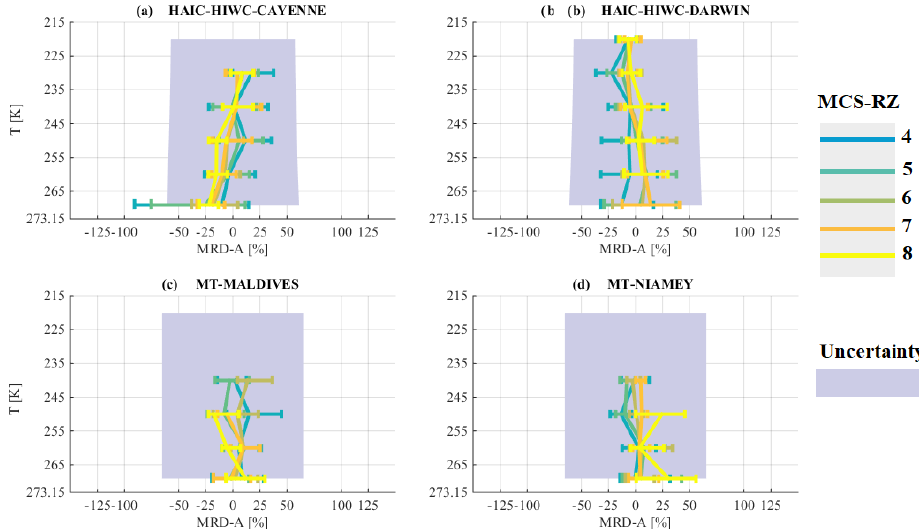
Figure 26. The same as Fig. 6 but for the ratio MRD- A